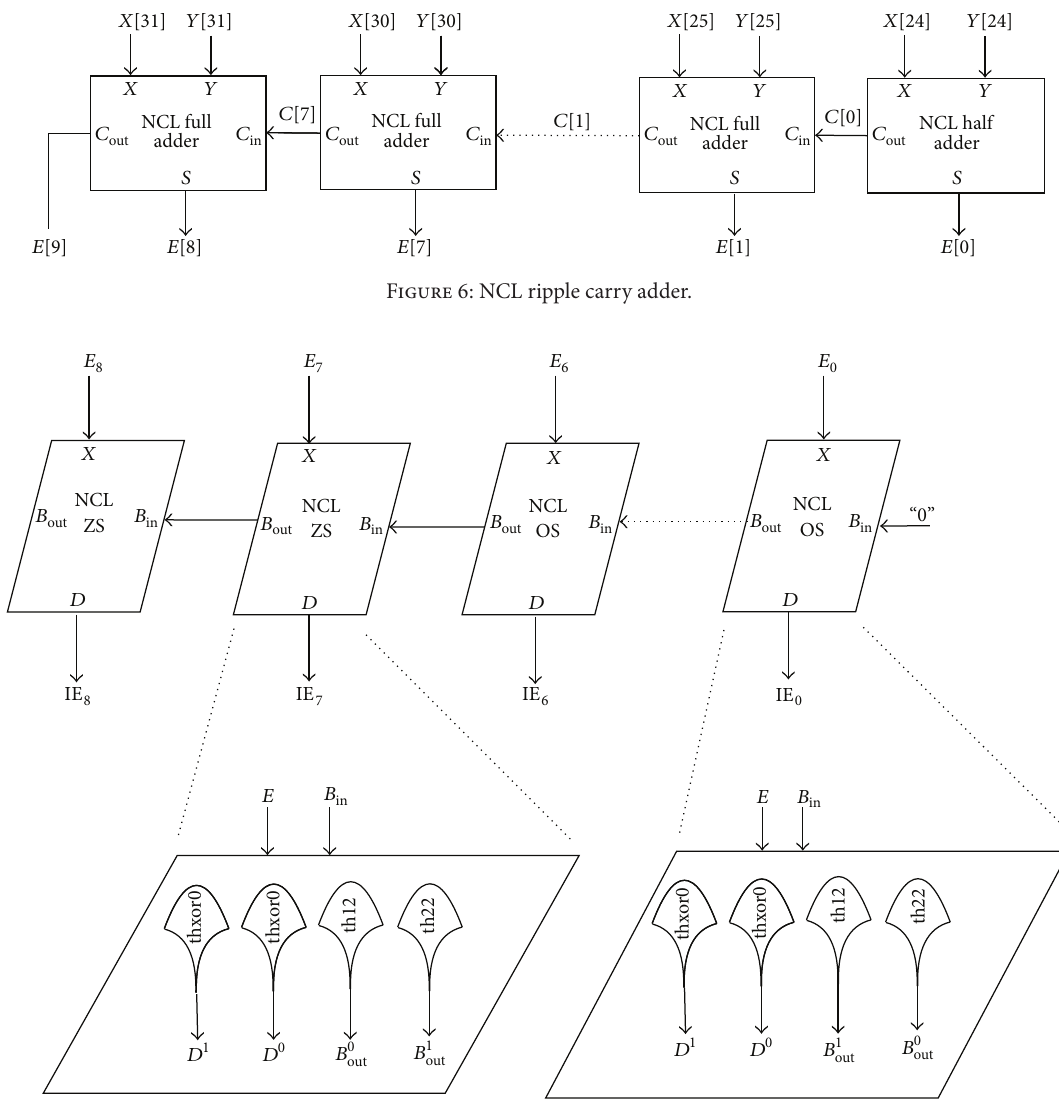
Figure 7: NCL ripple borrow